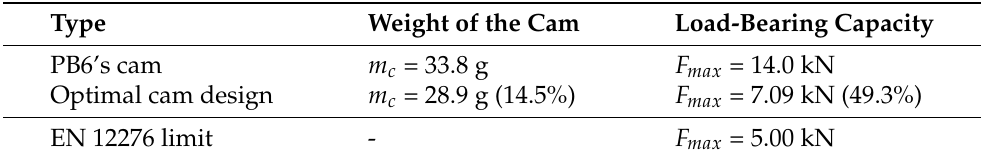
Table 9. Comparison of weights and load-bearing